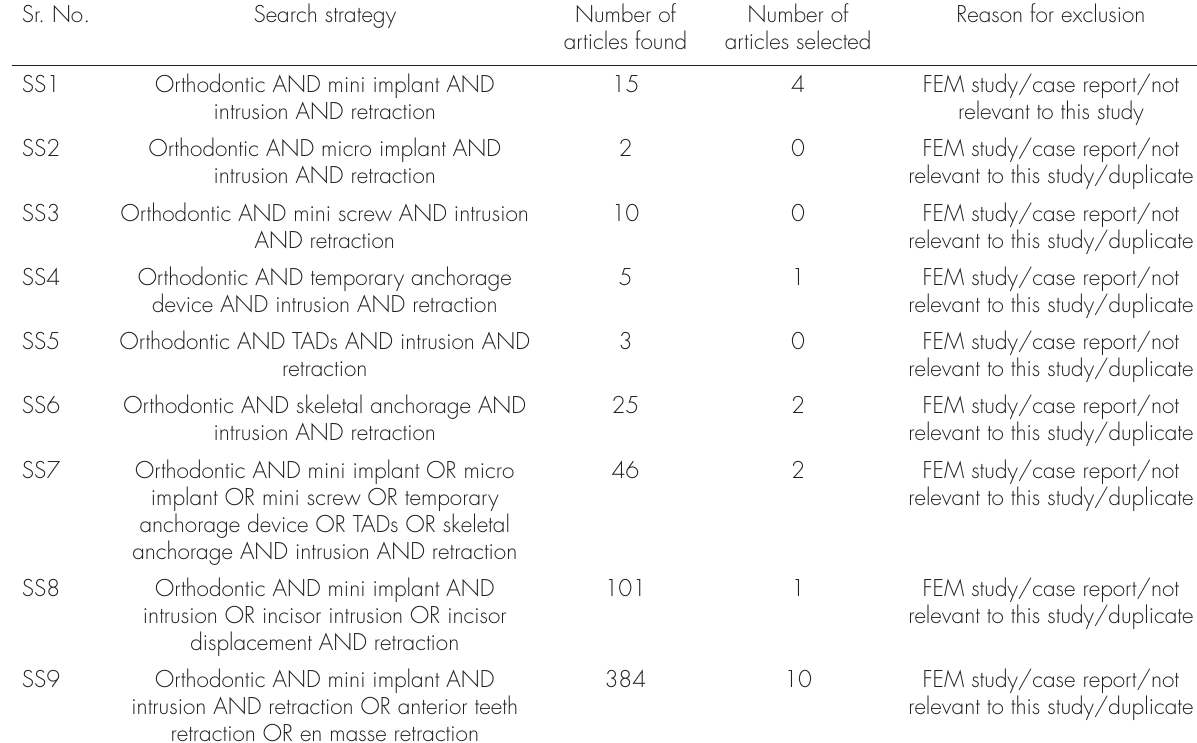
Table II. Search